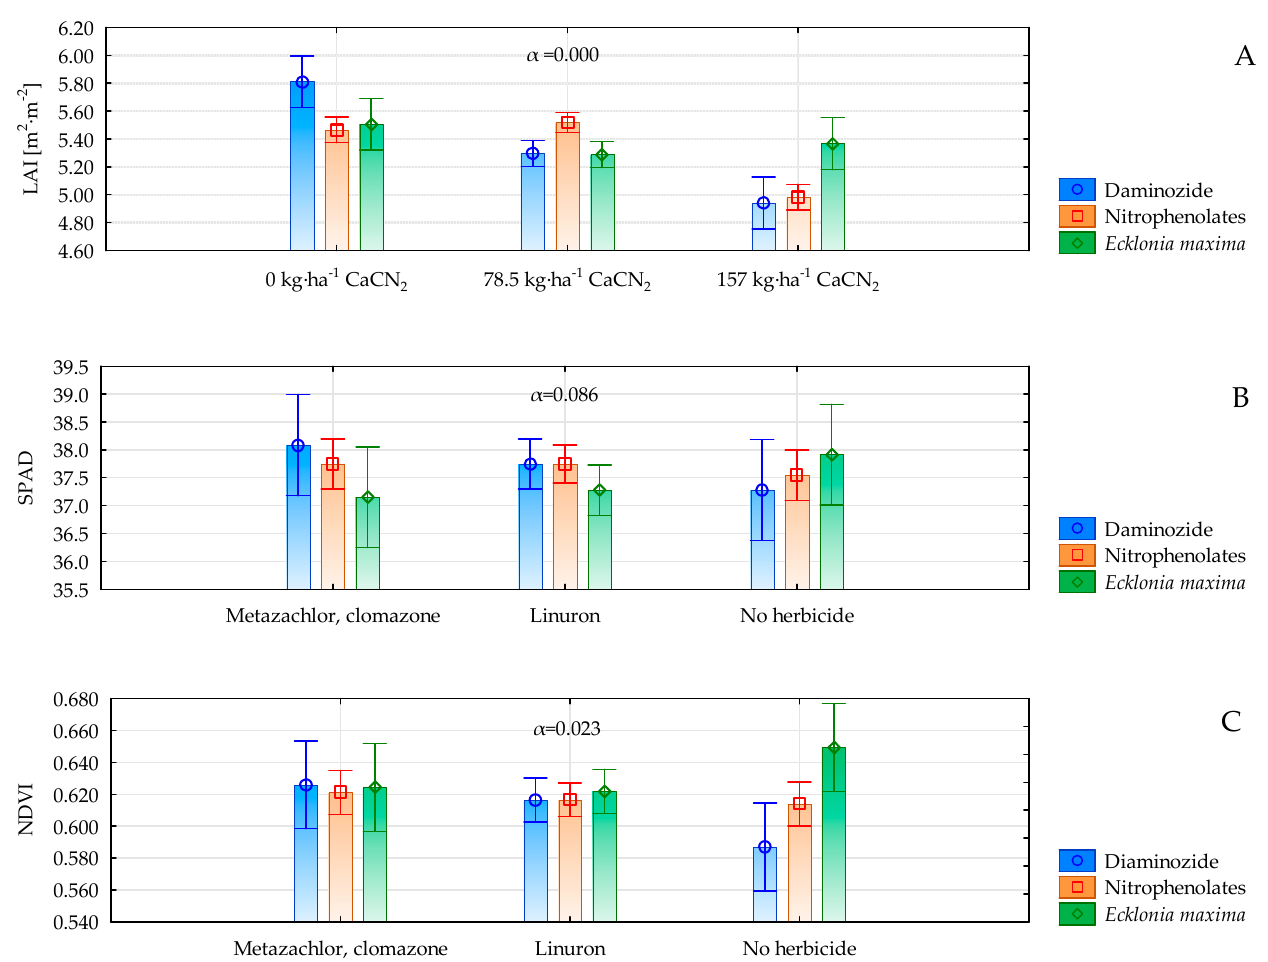
Figure 2. LAI ( A ), SPAD ( B ), and NDVI ( C ) of